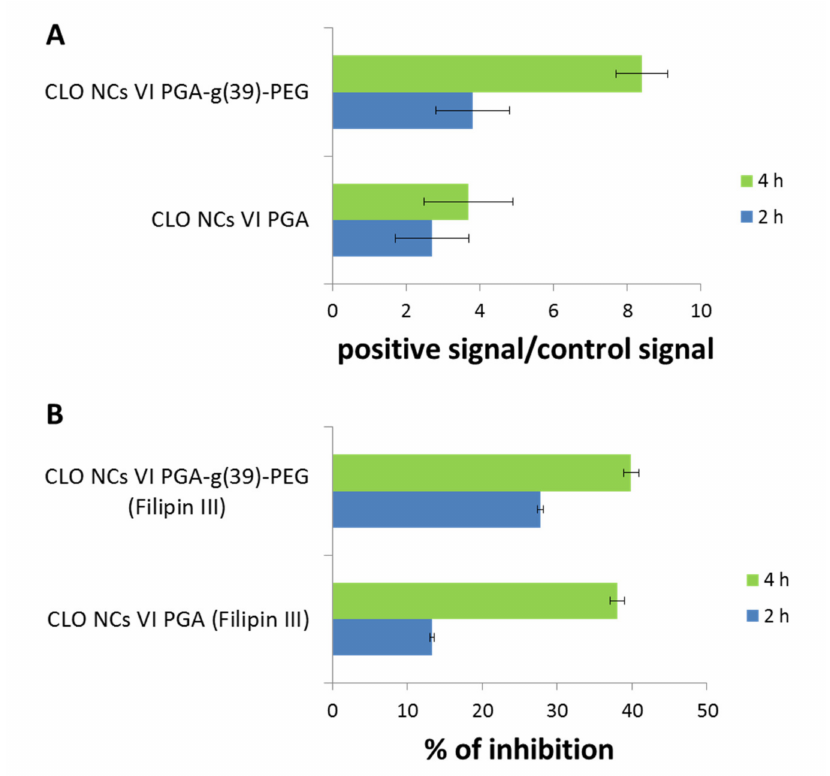
Figure 5. ( A ) Transcytosis experiment performed in hCMEC/D3 cells for CLO-NCs VI PGA and CLO-NCs VI PGA-g(39)-PEG (transwell pore-3mm). ( B ) Inhibition of the transcytosis process (incubation with filipin III—specific inhibitor of the process) for various types of CLO-NCs (detailed information